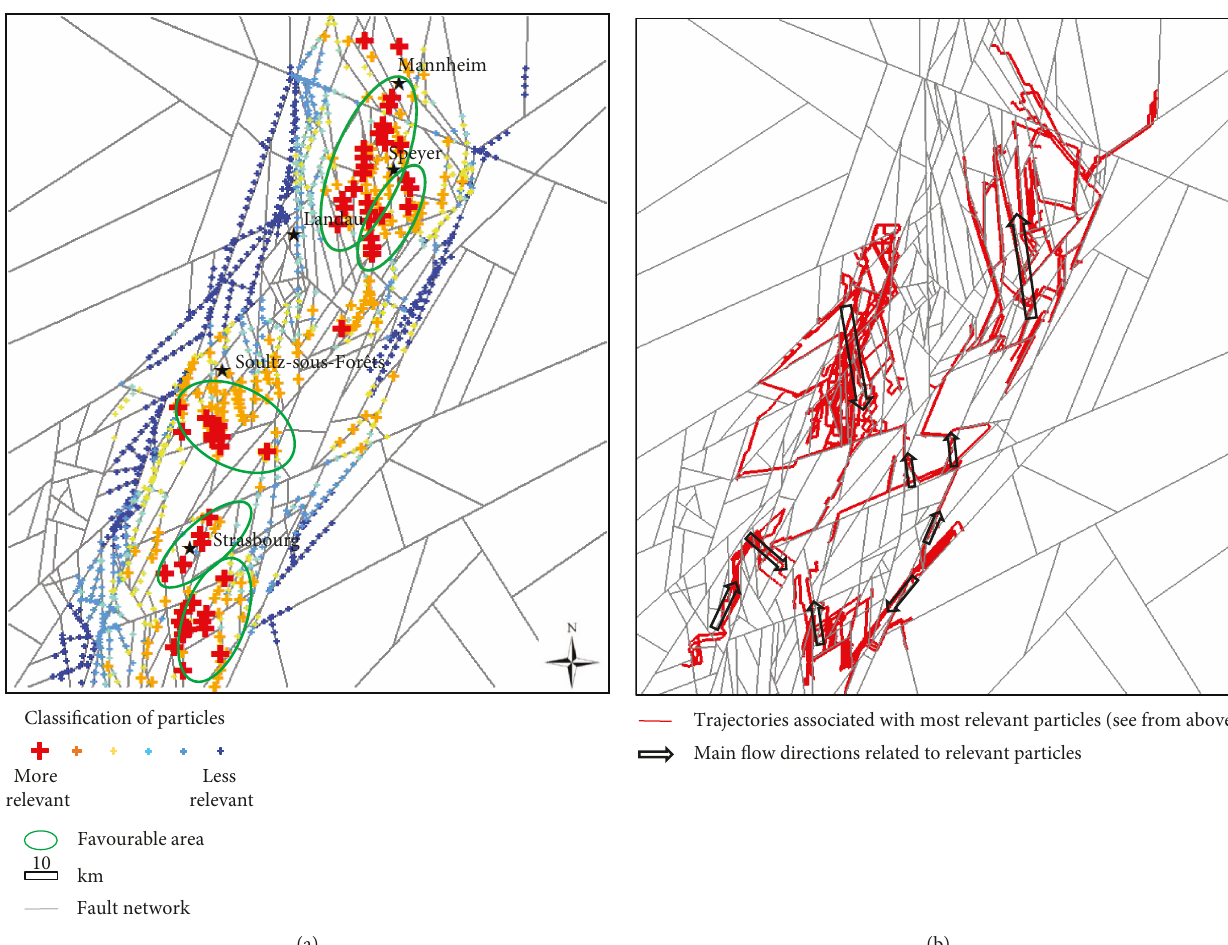
Figure 5: (a) Classi fi cation of particles resulting from the fl ow path analysis based on selection criteria and the respective delineated preferential target areas obtained (favourable areas are delineated by the green circles). Note that the particles are plotted at a 2 km depth upstream from the ending point of their trajectory. (b). Particle trajectories of the most relevant particles (red crosses) and the associated main fl ow